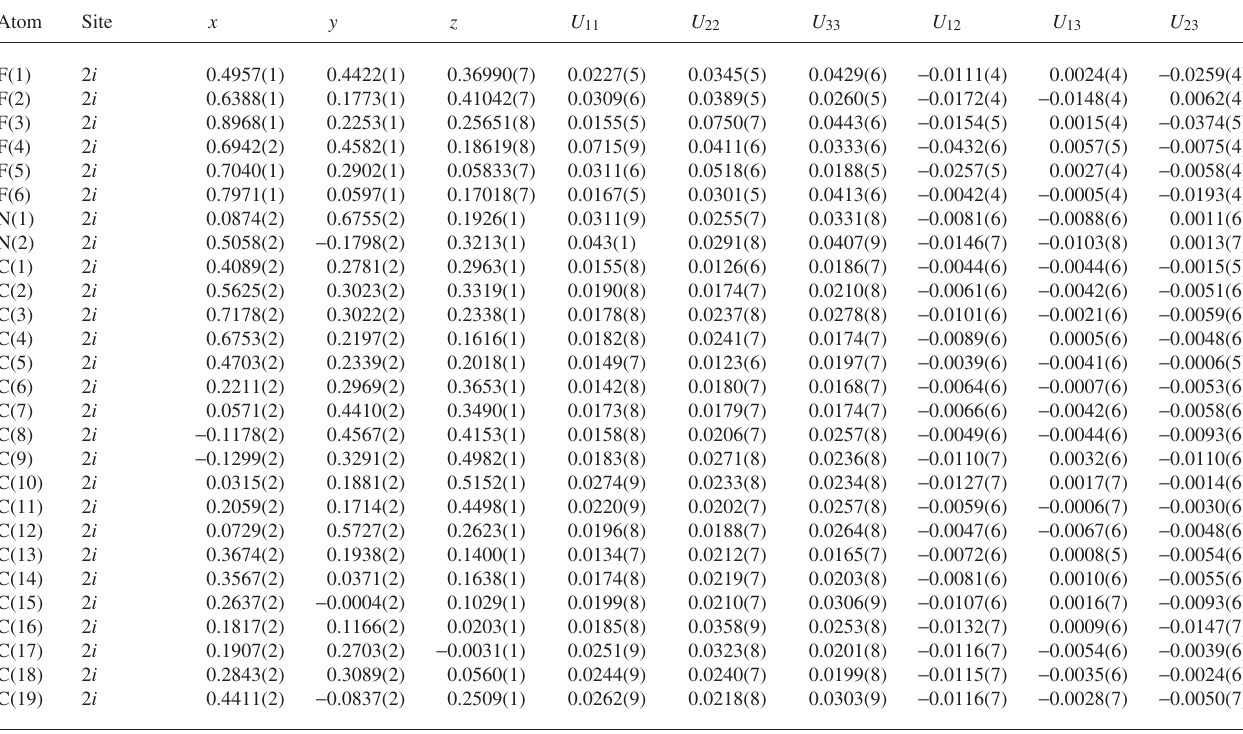
Table 3. Atomic coordinates and displacement parameters (in Å 2 ) .